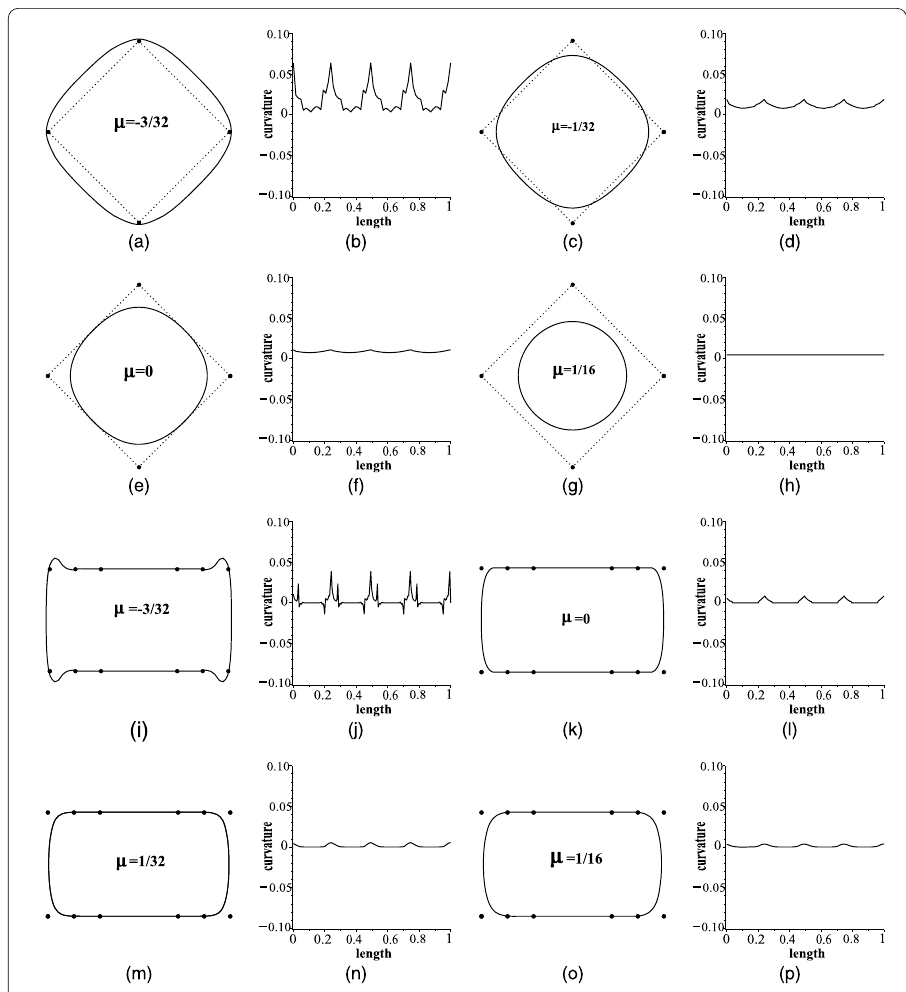
Figure 2 Four subdivision levels of SS (16) have been used to the control polygon. The results after different values of μ are shown on the left together with their corresponding curvature on the right